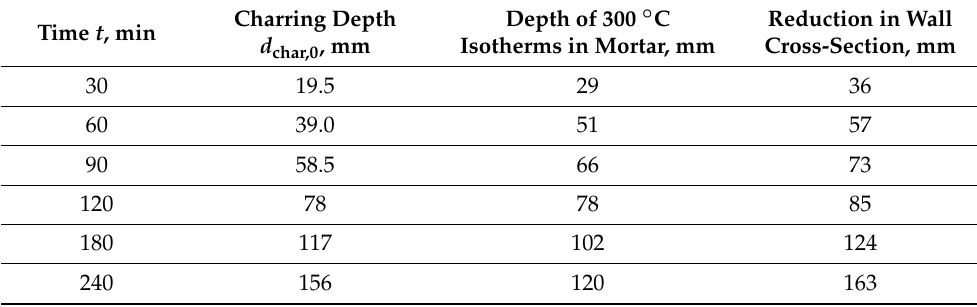
Figure 3. Depth of 300 °C isotherms for timber and concrete wall. Table 2. Depth of 300 °C isotherms for timber and mortar wall in case of double-sided fire for walls with thicknesses b equal to 200 mm, 300 mm and 400 mm and more.